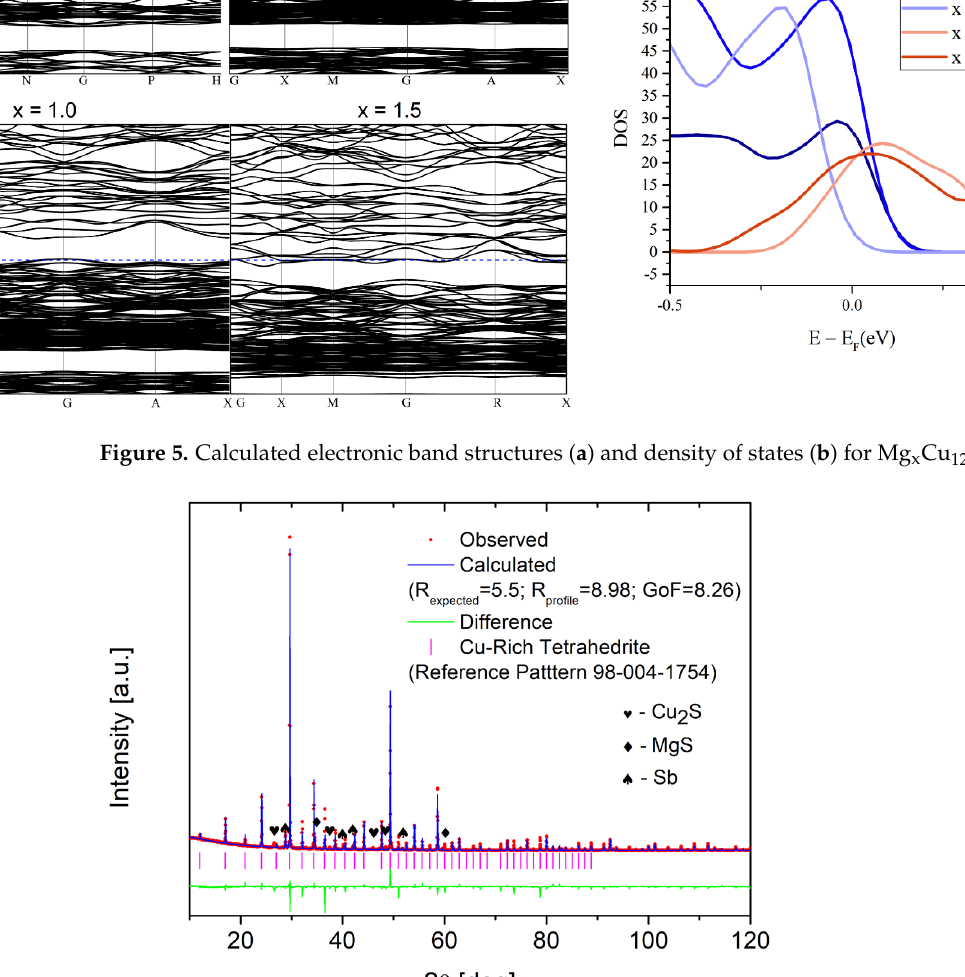
Figure 7. XRD diffraction patterns of Mg x Cu 12 Sb 4 S 13 specimens after synthesis. Figure 8. Lattice constants measured for tetrahedrite phases present in Mg x Cu 12 Sb 4 S 13 samples after sintering ( a ) and weight fraction of the high lattice constant phase in these samples ( b ) .